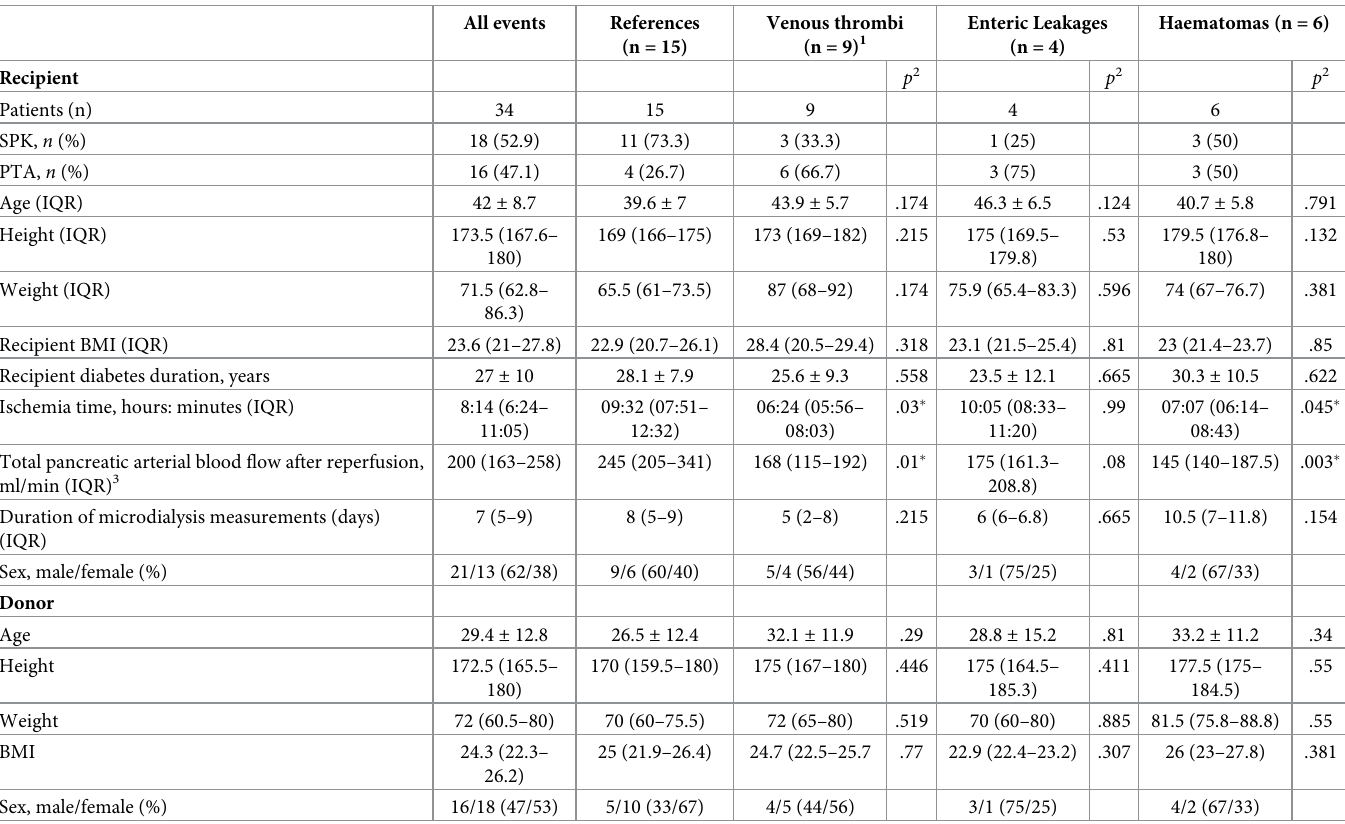
Table 1. Donor and patient characteristics in 34 consecutive pancreas transplantations, all transplantations and by event